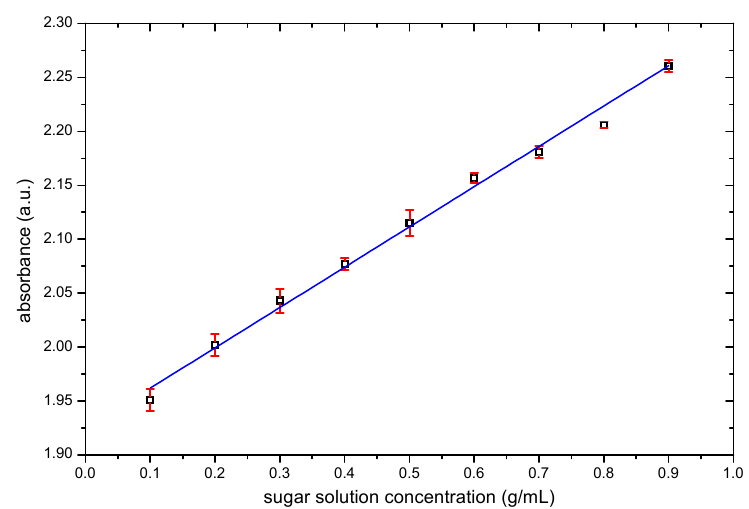
Figure 1. Calibration curve for sucrose solutions; squares represent the experimental data, and the solid line is used as a reference for the eye.